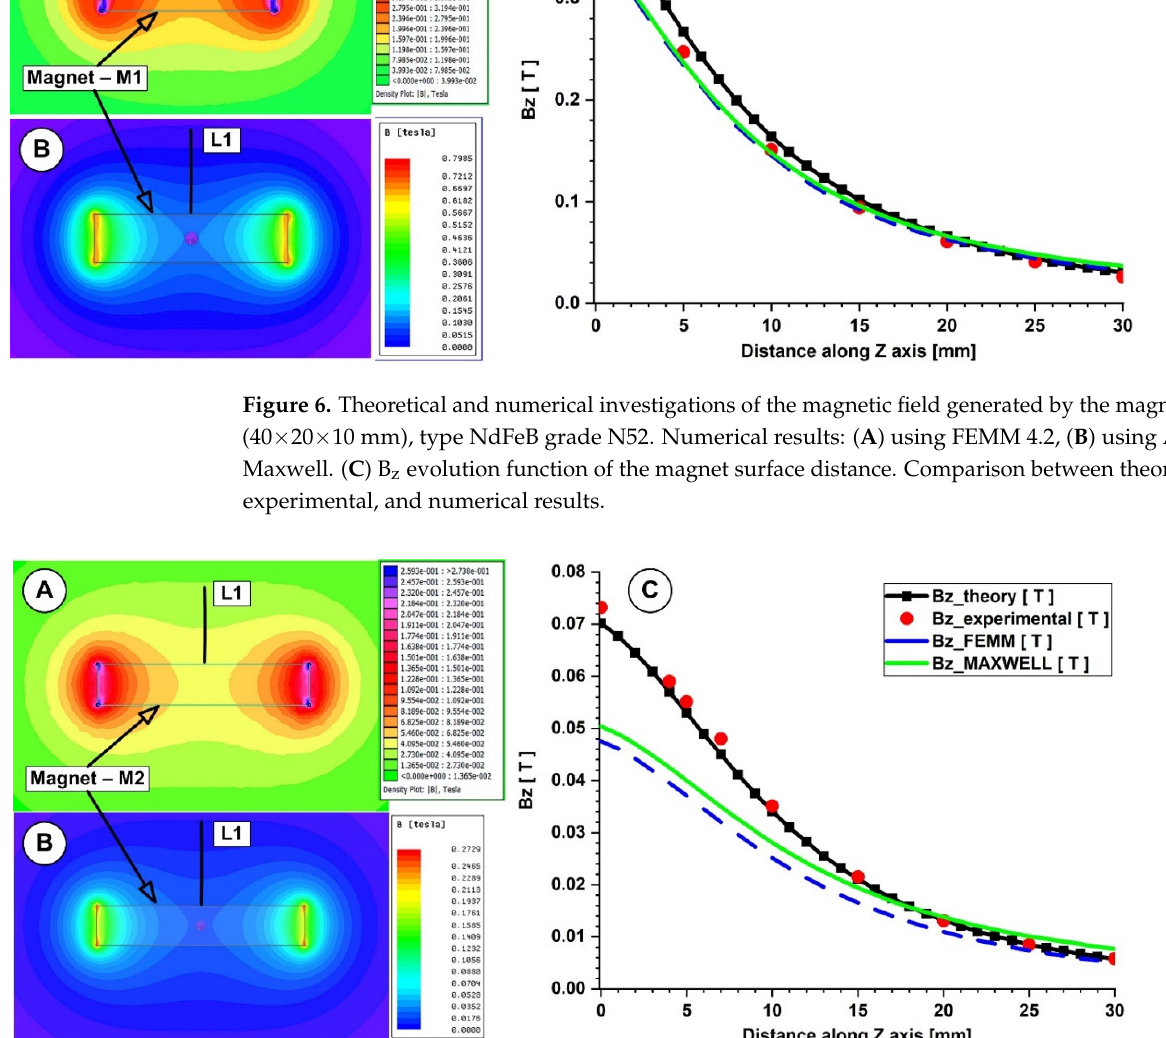
Figure 7. Theoretical and numerical investigations of the magnetic field generated by the magnet M2 (29×26×5 mm), type ferrite grade Y35. Numerical results: ( A ) using FEMM 4.2, ( B ) using Ansys Maxwell. ( C ) B z evolution function of the magnet surface distance. Comparison between theoretical, experimental, and numerical results.